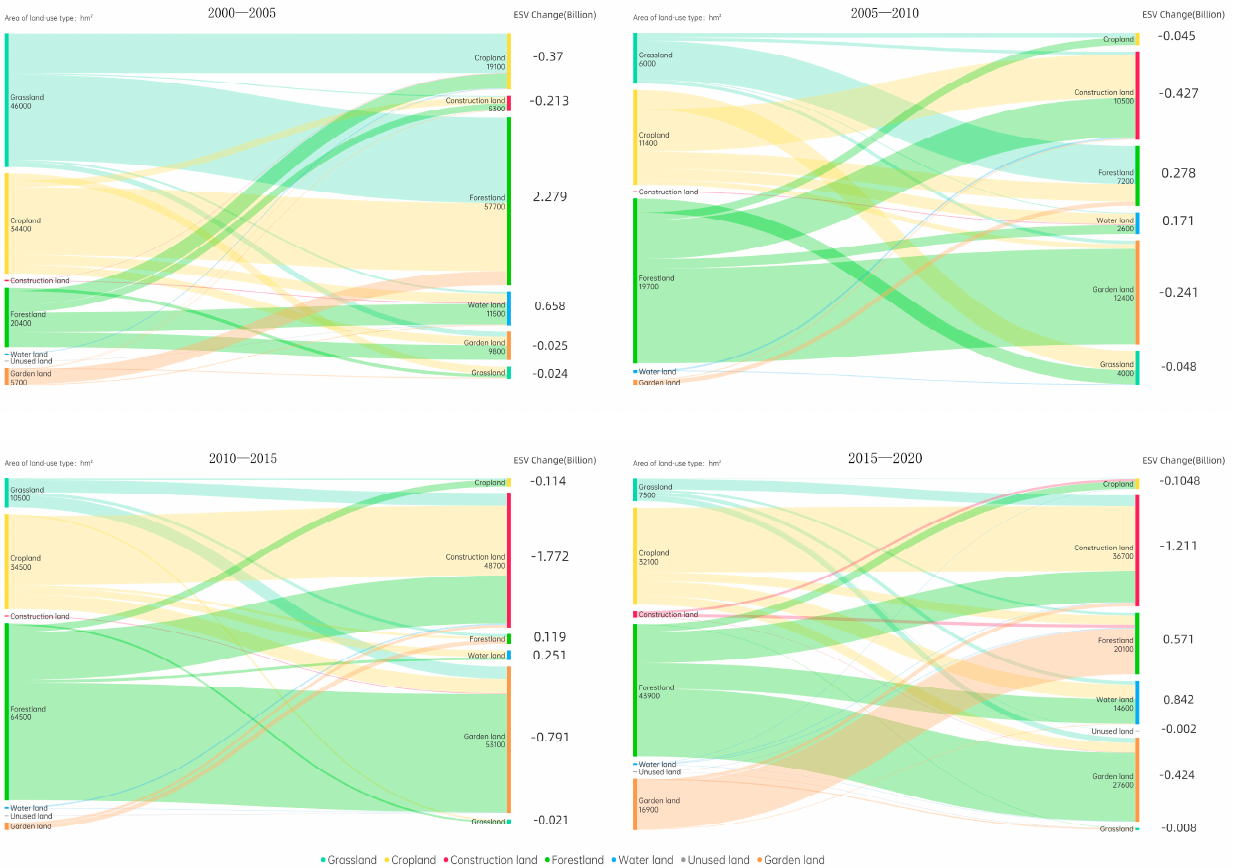
Figure 4. Mulberry map of land-use changes in the Wuling Mountains by period.